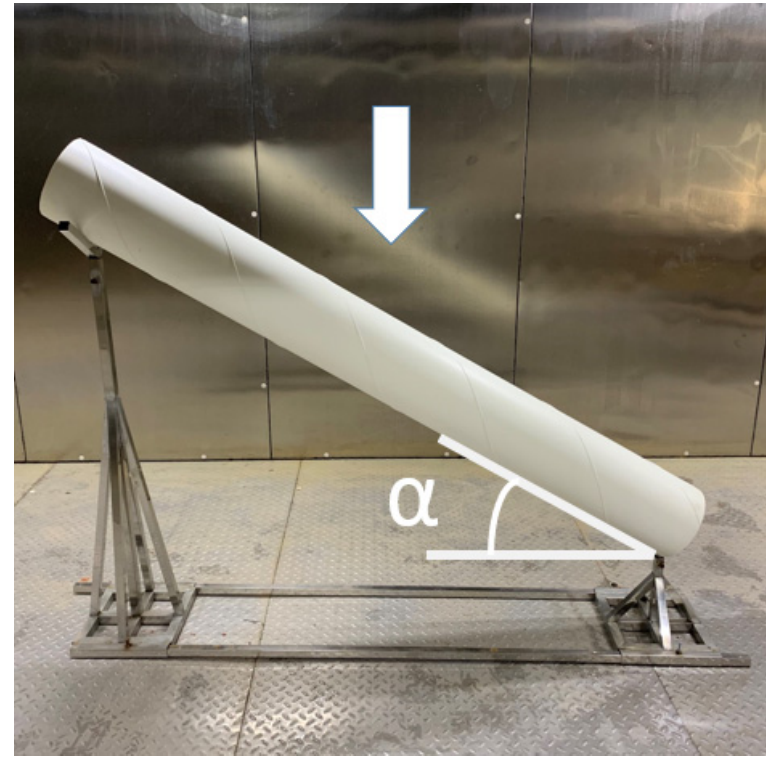
Figure 2. Climatic chamber rig with cables.